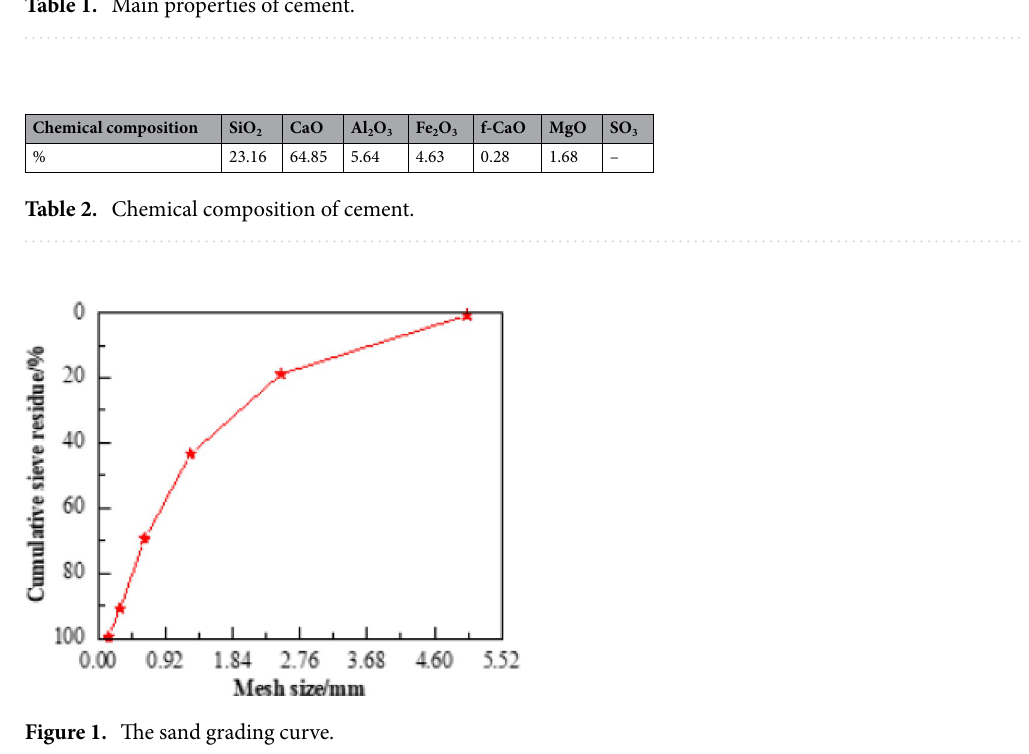
Table 1. Main properties of cement.